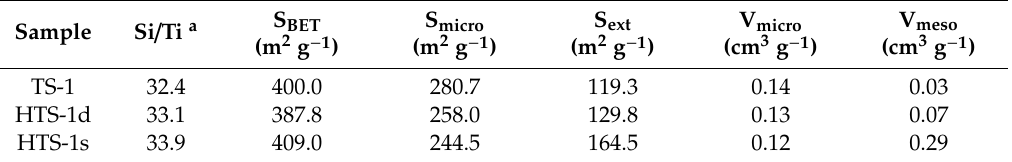
Figure 1. N 2 adsorption-desorption isotherms ( a ) and pore size distributions ( b ) of hierarchical titanium silicalite-1 (HTS-1) samples. Table 1. Compositions and textural properties of titanium silicalite-1 (TS-1) and HTS-1 zeolites.